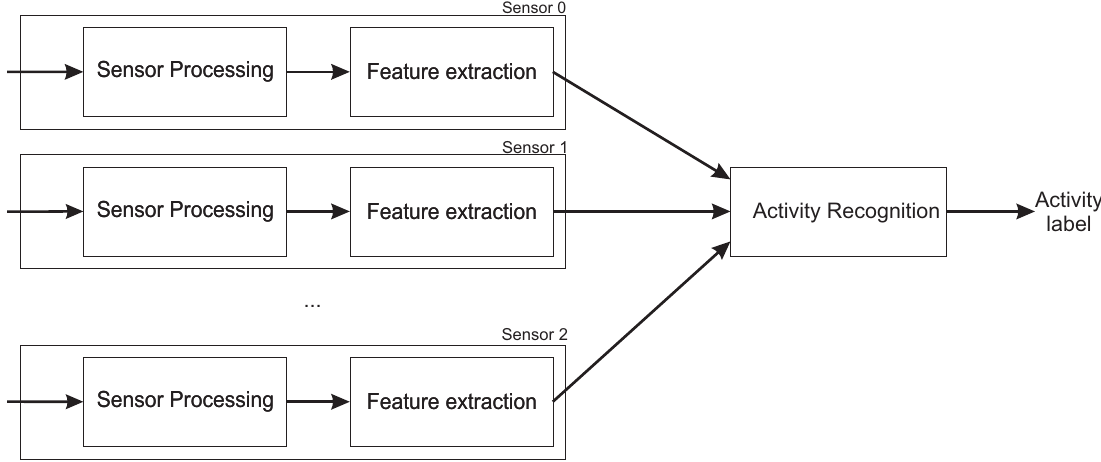
Figure 1. Overview of the activity recognition process from multiple